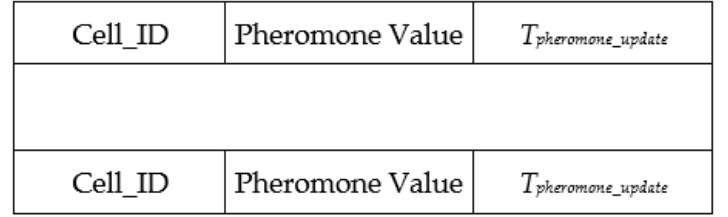
Figure 2. Data table format for storing a global pheromone map.